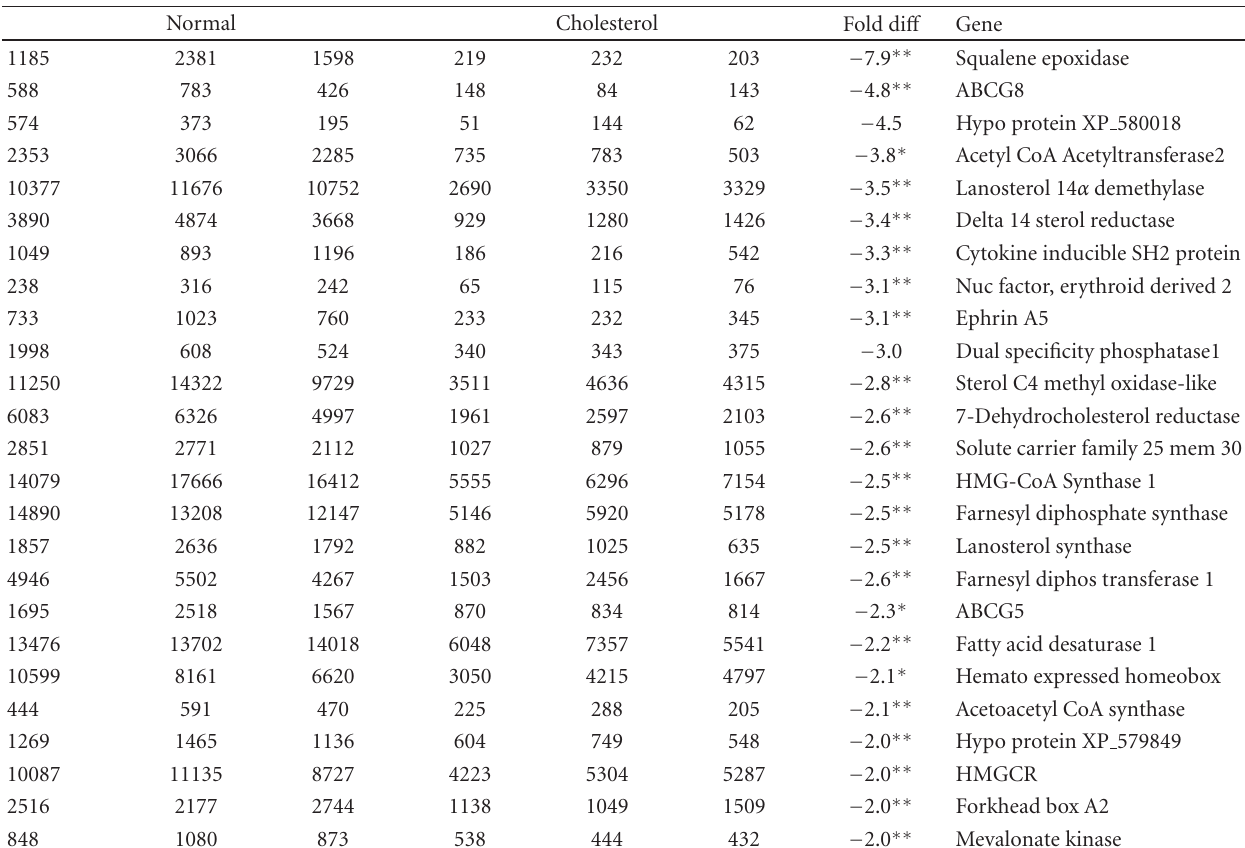
Table 4: Microarray analysis identifying genes downregulated by dietary